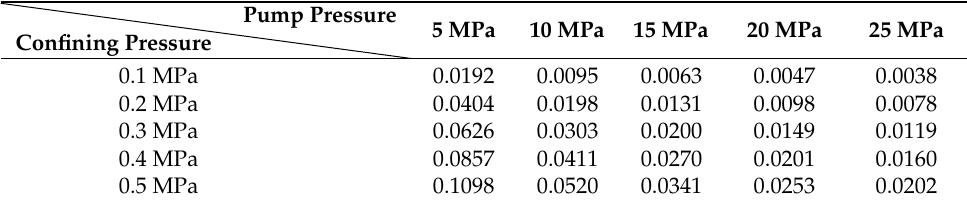
Table 3. Cavitation Numbers in Different Pump Pressures and Cavity’s Confining Pressures.